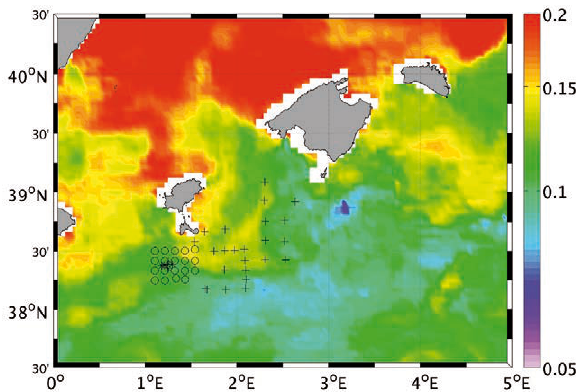
Fig . 2. – Front location. Satellite image of Chl a concentration dur- ing one week around 21 June, 2010 derived from MODIS Aqua. Symbols for sampling stations as in Figure